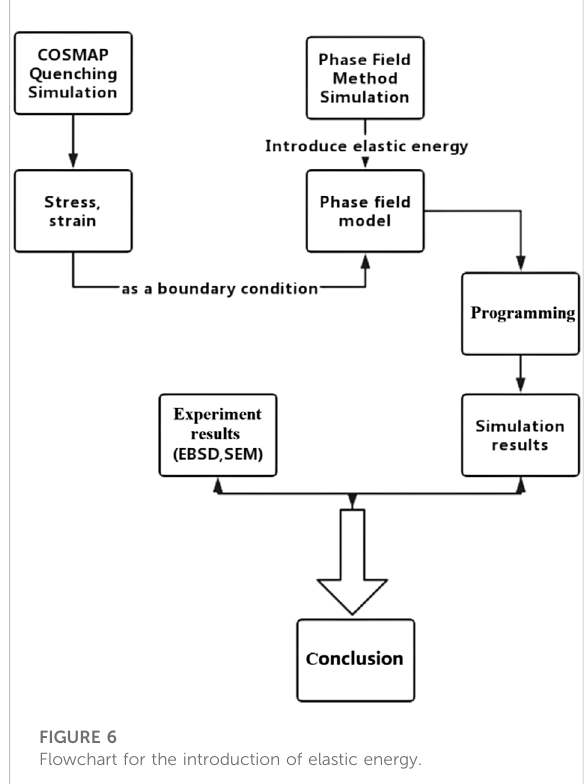
FIGURE 6 Flowchart for the introduction of elastic